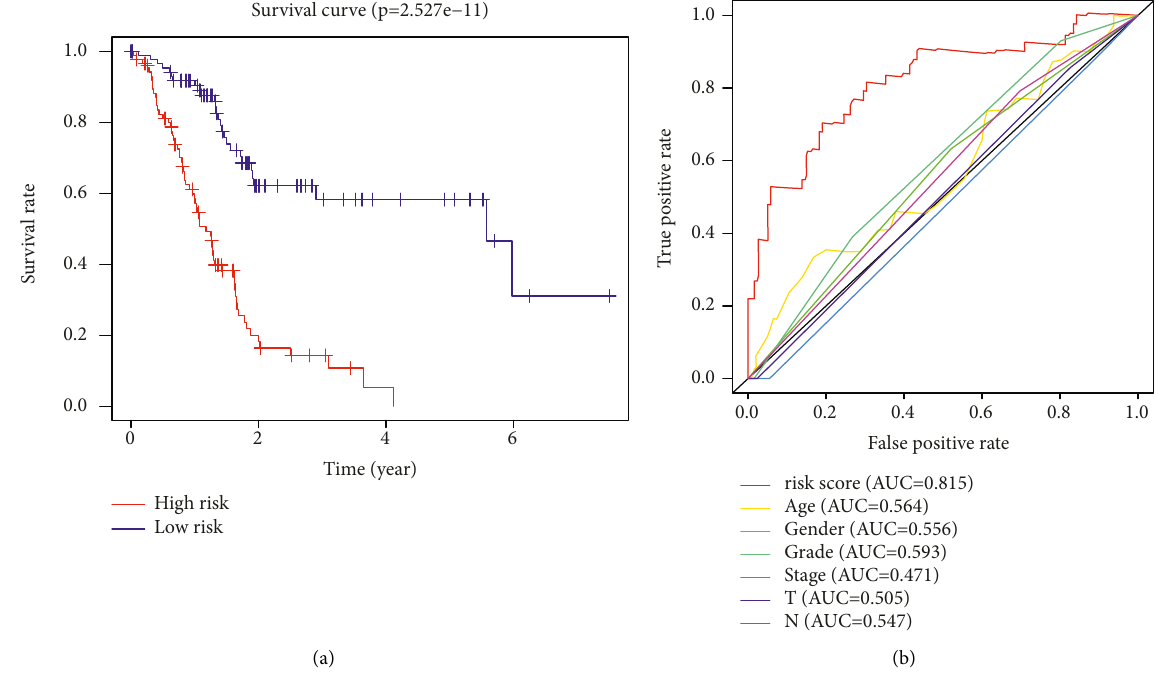
Figure 6: Prognostic impact of the risk signature. (a) Kaplan–Meier survival curve of the risk model. (b) Risk score of the ROC curve and other clinical factors based on the AUC. AUC, acute area under the curve.